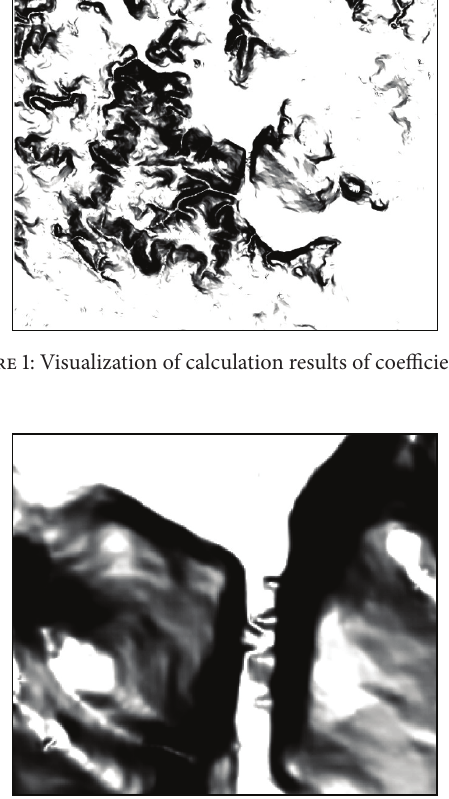
Figure 2: Visualization of calculation resultsof coefficient 𝐶 1